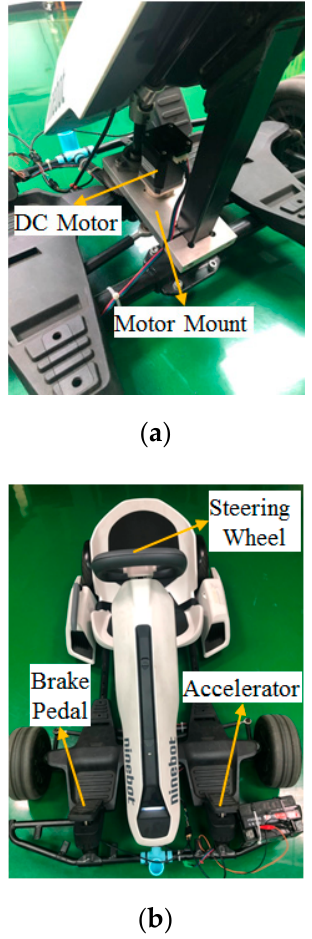
Figure 12. ( a ) The hardware configuration of steer-by-wire in a real go kart; ( b ) hardware configuration of drive-by-wire using the steering wheel, accelerator and brake pedal.